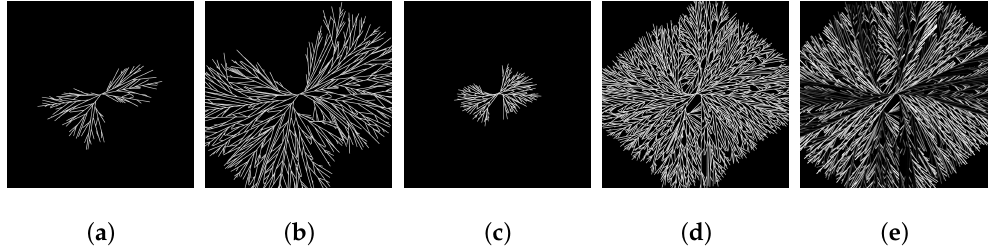
Figure 5. ( a – d ): Simulation results for the growth of a single spherulite at different time steps with a resulting degree of crystallization of ( a , b ): 25% and ( c , d ): 38% ( e ): angle-dependent depiction of a simulated spherulite.